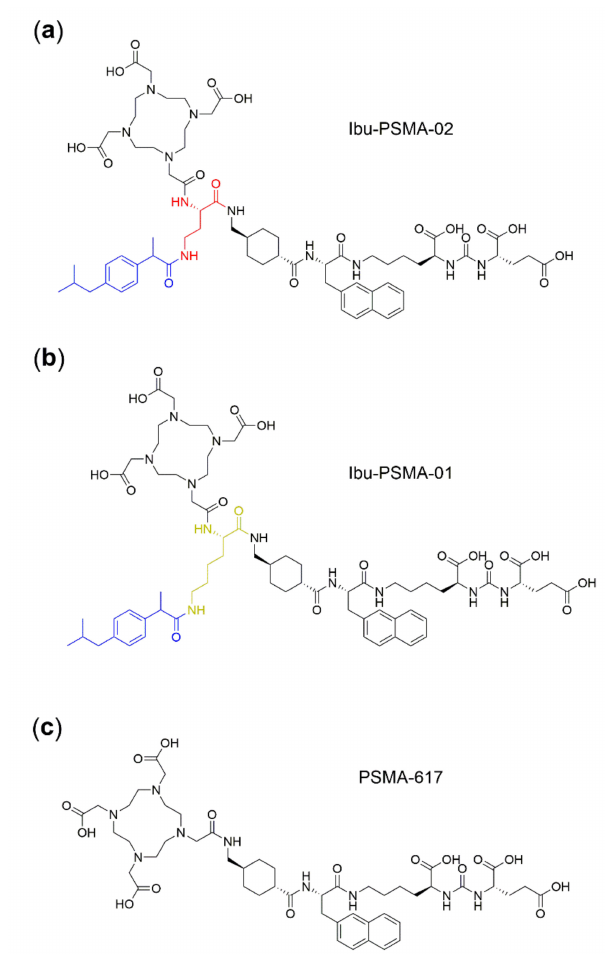
Figure 1. Chemical structure of prostate-specific membrane antigen (PSMA) ligands. ( a ) Novel ligand, Ibu-PSMA-02, with a diaminobutyric acid entity as connecting entity (red) to conjugate ibuprofen (blue);